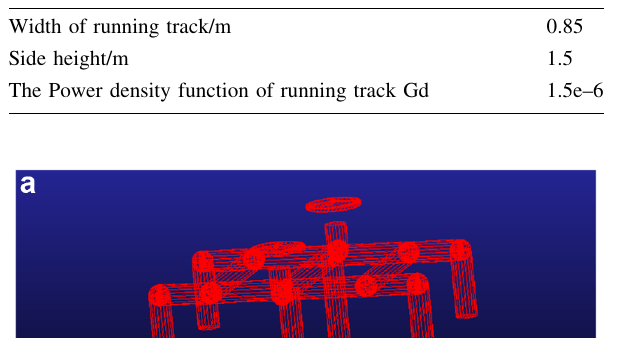
Table 4 Parameter of the track